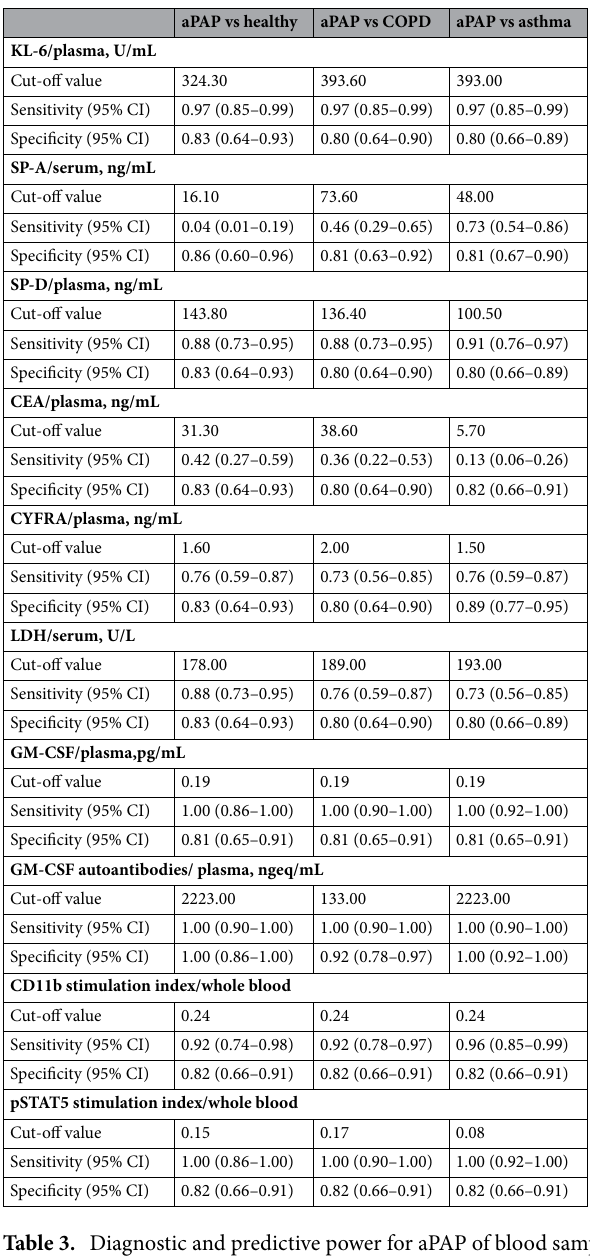
Table 3. Diagnostic and predictive power for aPAP of blood sample biomarkers (specificity ≥ 80%) [per-protocol biomarker analysis]. aPAP autoimmune pulmonary alveolar proteinosis, CD11b cluster of differentiation molecule 11b, CEA carcinoembryonic antigen, CI confidence interval, COPD chronic obstructive pulmonary disease, CYFRA cytokeratin-fragment, GM-CSF granulocyte–macrophage colony- stimulating factor, KL-6 Krebs von den Lungen 6, LDH lactate dehydrogenase, pSTAT5 phosphorylated signal transducer and activator of transcription 5, SD standard deviation, SP-A surfactant protein-A, SP-D surfactant